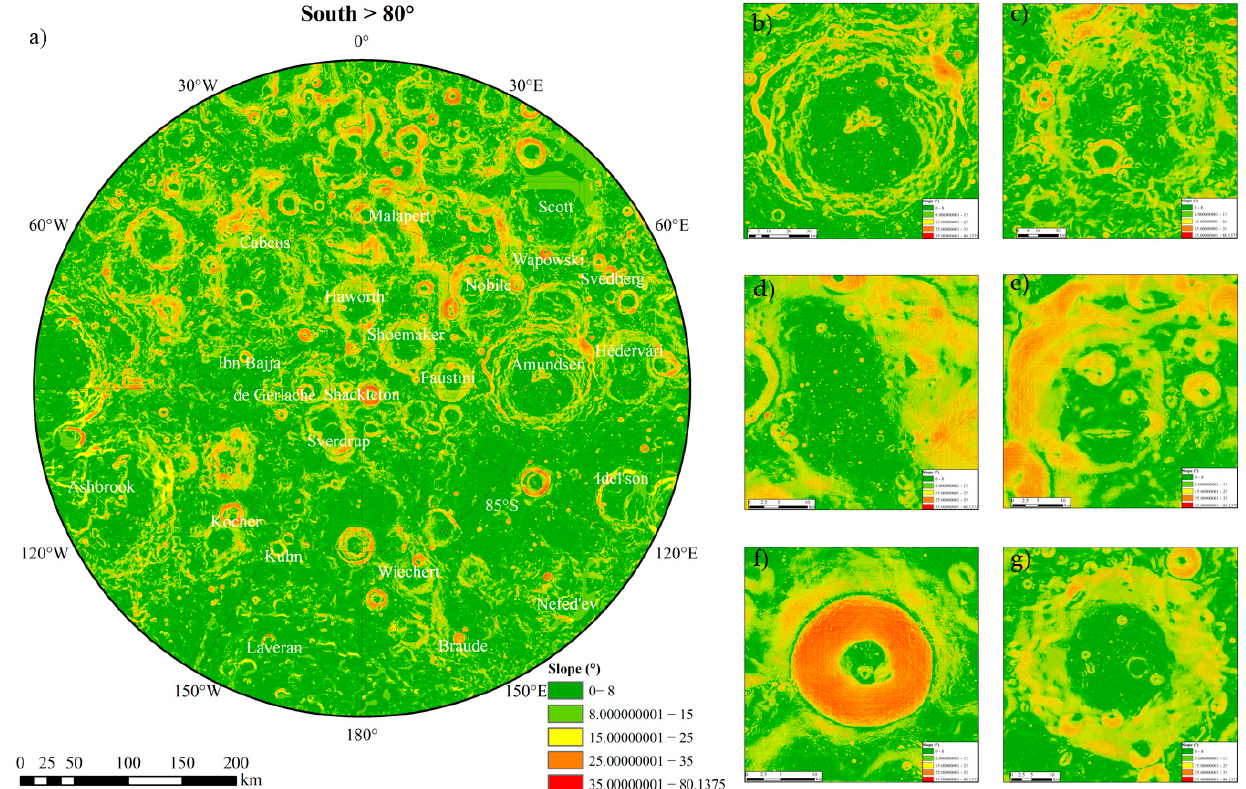
Figure 13. ( a ). Slopes in the lunar south pole areas above 80° altitude (Chang ‘E-2 DEM 20m/pixel). For instance: ( b ) Amundsen impact crater; ( c ) de Gerlache impact crater; ( d ) Malapert impact crater; ( e ) Nobile impact crater; ( f ) Shackleton impact crater; and ( g ) Shoemaker impact crater.